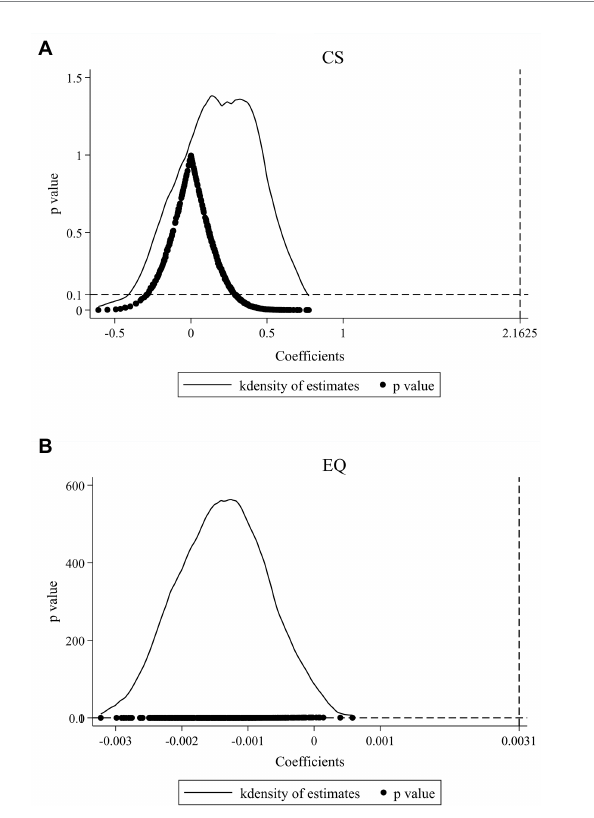
FIGURE 4 The placebo test of CS (A) and EQ (B) . The X-axis is the coefficients of DID for the 500 random processes. The vertical lines on the right side are the baseline coefficients of DID, all significantly located in the low- tailed of the kernel density